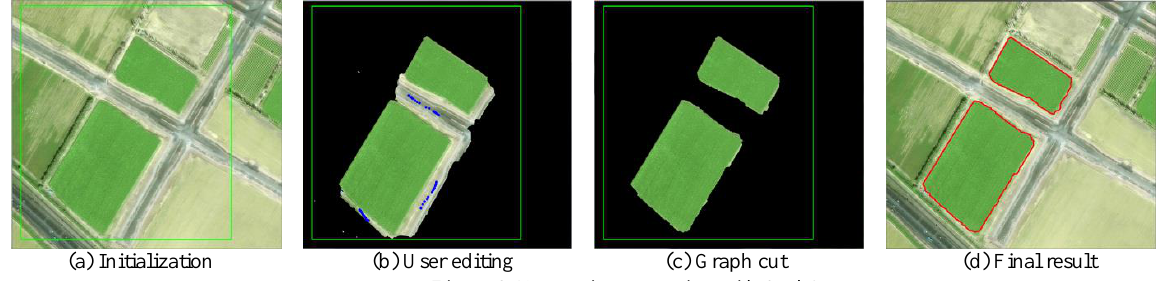
Figure 6. Vegetation extraction with